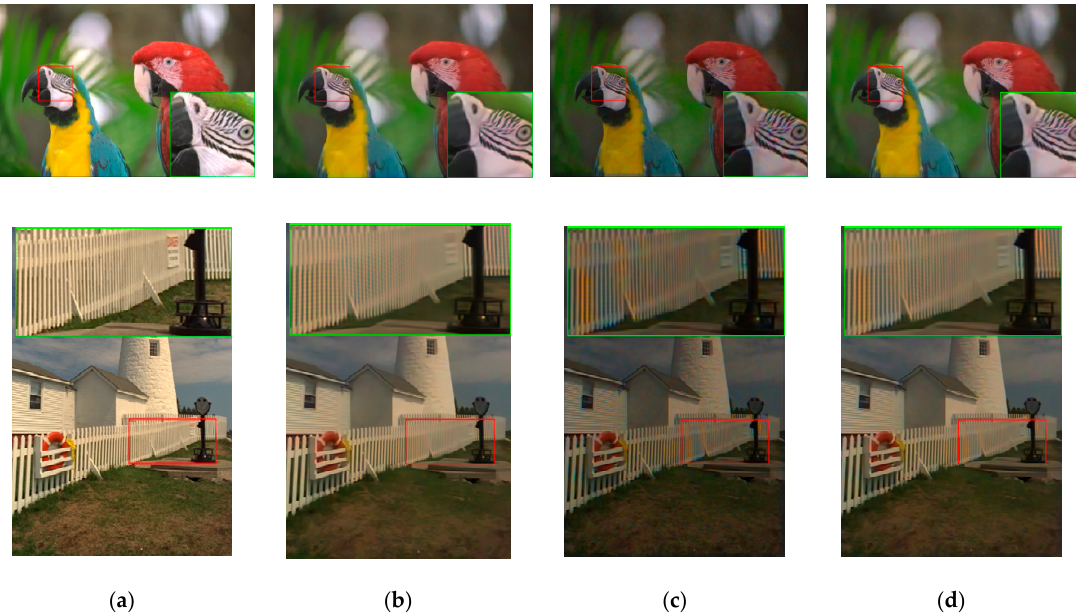
Figure 11. Visual comparison of three high performing demosaicing algorithms at 10 dBs SNR (Poisson noise). The top row is the bird image and the bottom row is the lighthouse image. ( a ) Ground